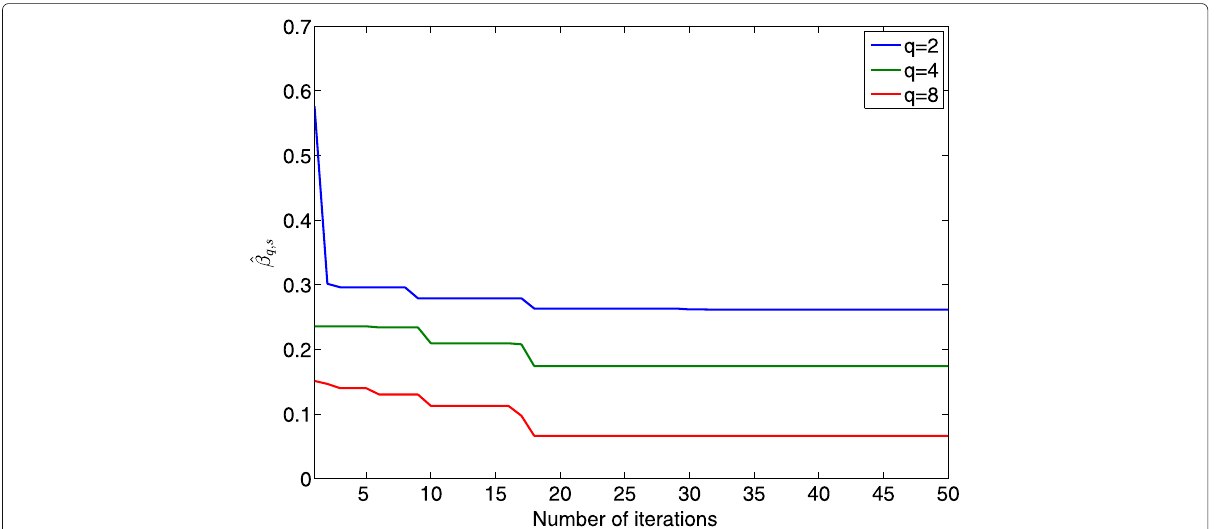
Fig. 1 q -ratio BCMSVs calculated for a Bernoulli random matrix of size 40 × 64 with n = 4, s = 4, and q = 2,4,8 as a function of number of